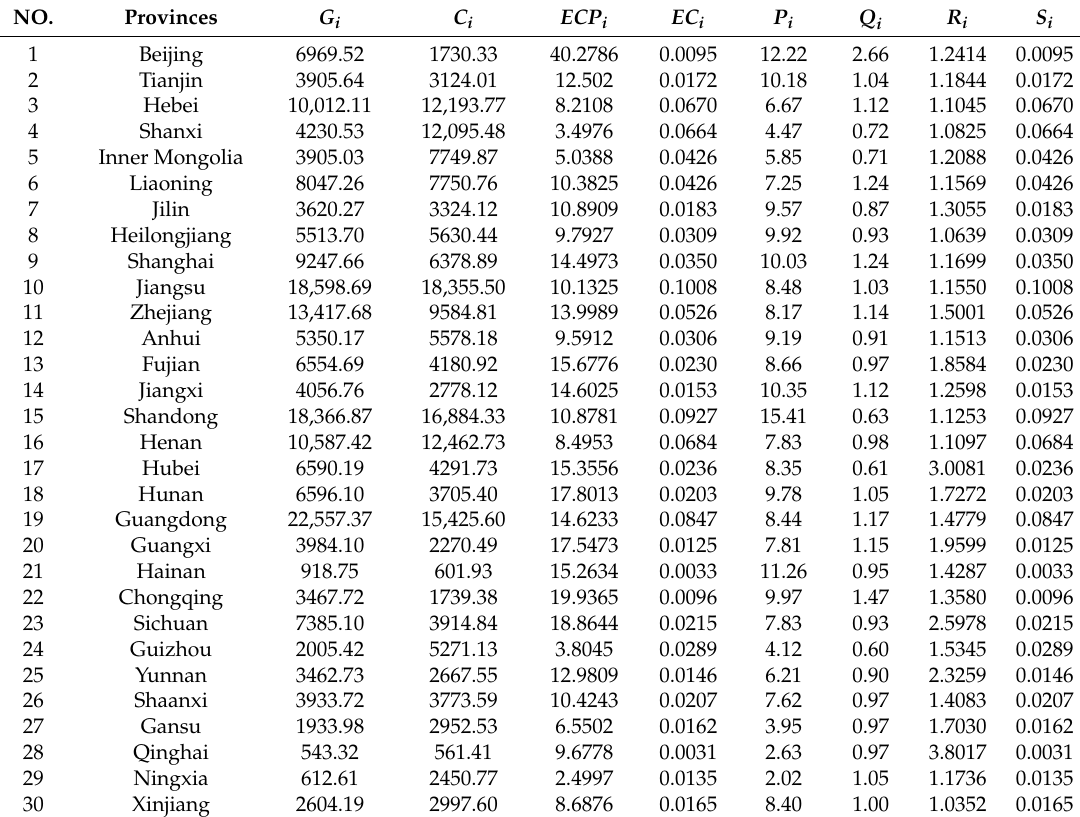
Table A1. The original data for parameters in